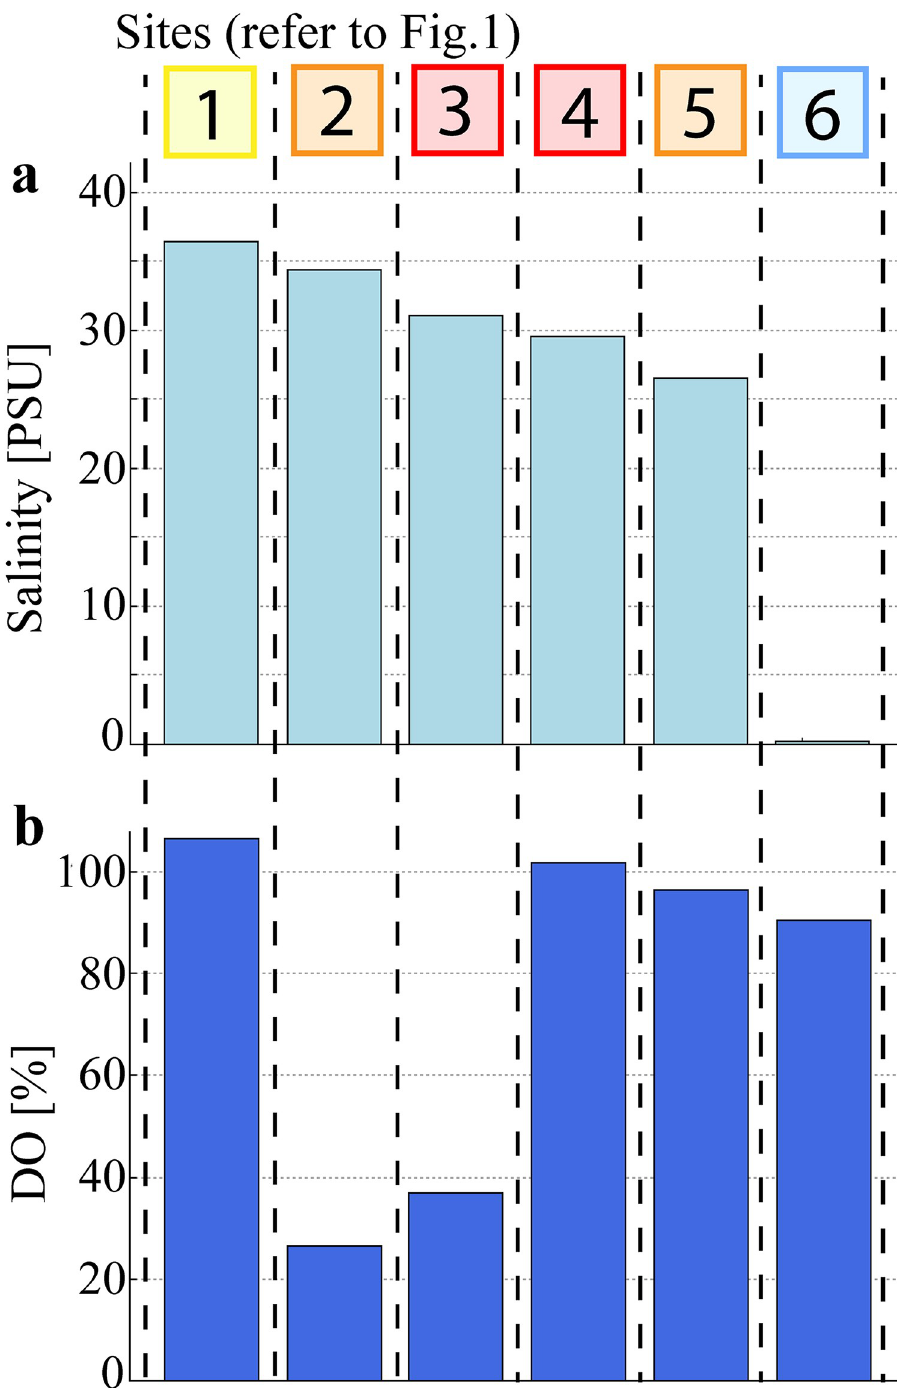
Fig 2. Average physicochemical parameters in the water column of the Burnett River estuary for each